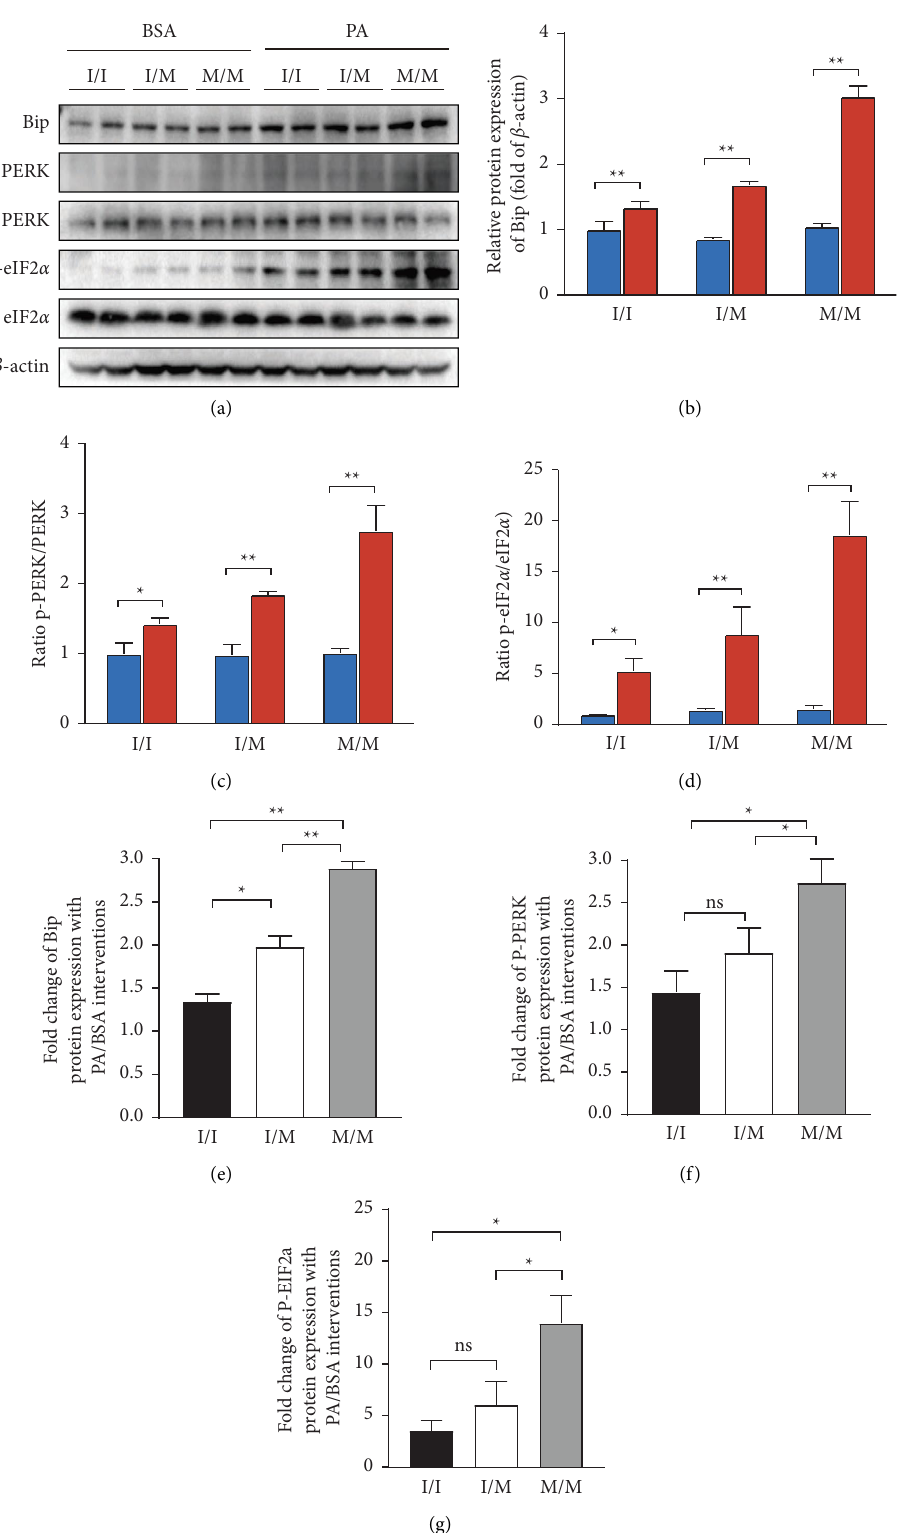
Figure 3: The protein expression of molecules involved in the ER stress responsive PERK pathway. (a) The protein level of Bip and total and phosphorylation levels of PERK and eIF-2a protein detected by western blot. (b–d) The quantitative analysis of gray value based (a) performed using image-pro plus software. (e–g) Fold change (PA/BSA) of (b–d). Biological replicates ( N � 3) were performed per group. Quantitative data are presented as the mean ± SD ( N � 3 independent experiments). ∗ P < 0 . 05; ∗∗ P < 0 .